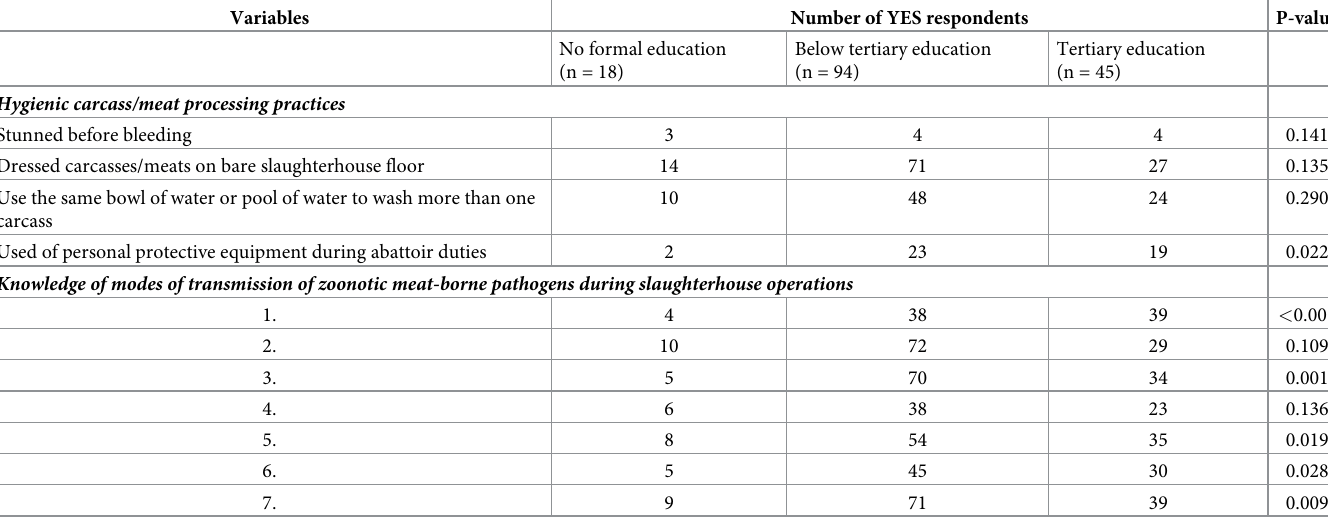
Table 3. Association between educational levels of slaughterhouse workers (n = 157) and their hygienic meat processing practices and knowledge on modes of trans- mission of meat-borne zoonotic pathogen during routine slaughterhouse operations in Southeast,